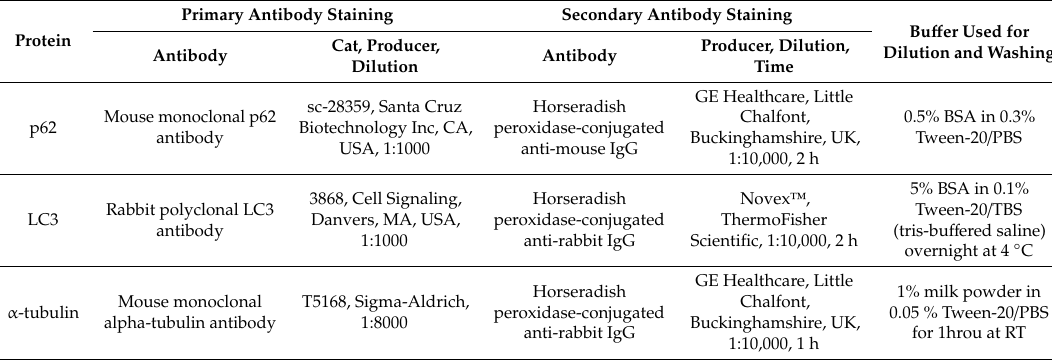
Table 2. The antibodies and dilution bu ff ers used for Western